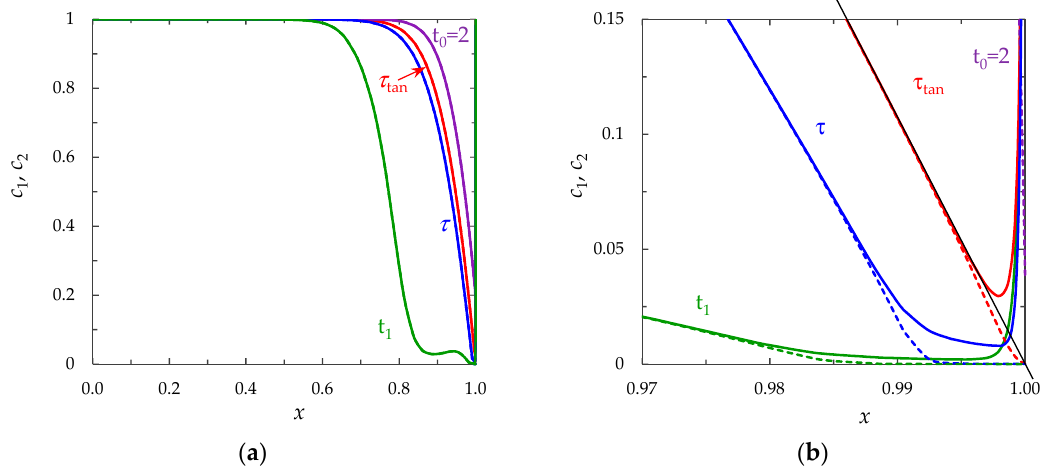
Figure 3. ( a ) Concentration profiles of cations ( c 1 , solid lines) and anions ( c 2 , dashed lines) in section y = 0.9 l at different instants of time: t 0 = 2, τ tan = 3.15, τ = 3.95, t 1 = 17, calculated at i av / i lim = 2; ( b ) enlarged fragment of ( a ).